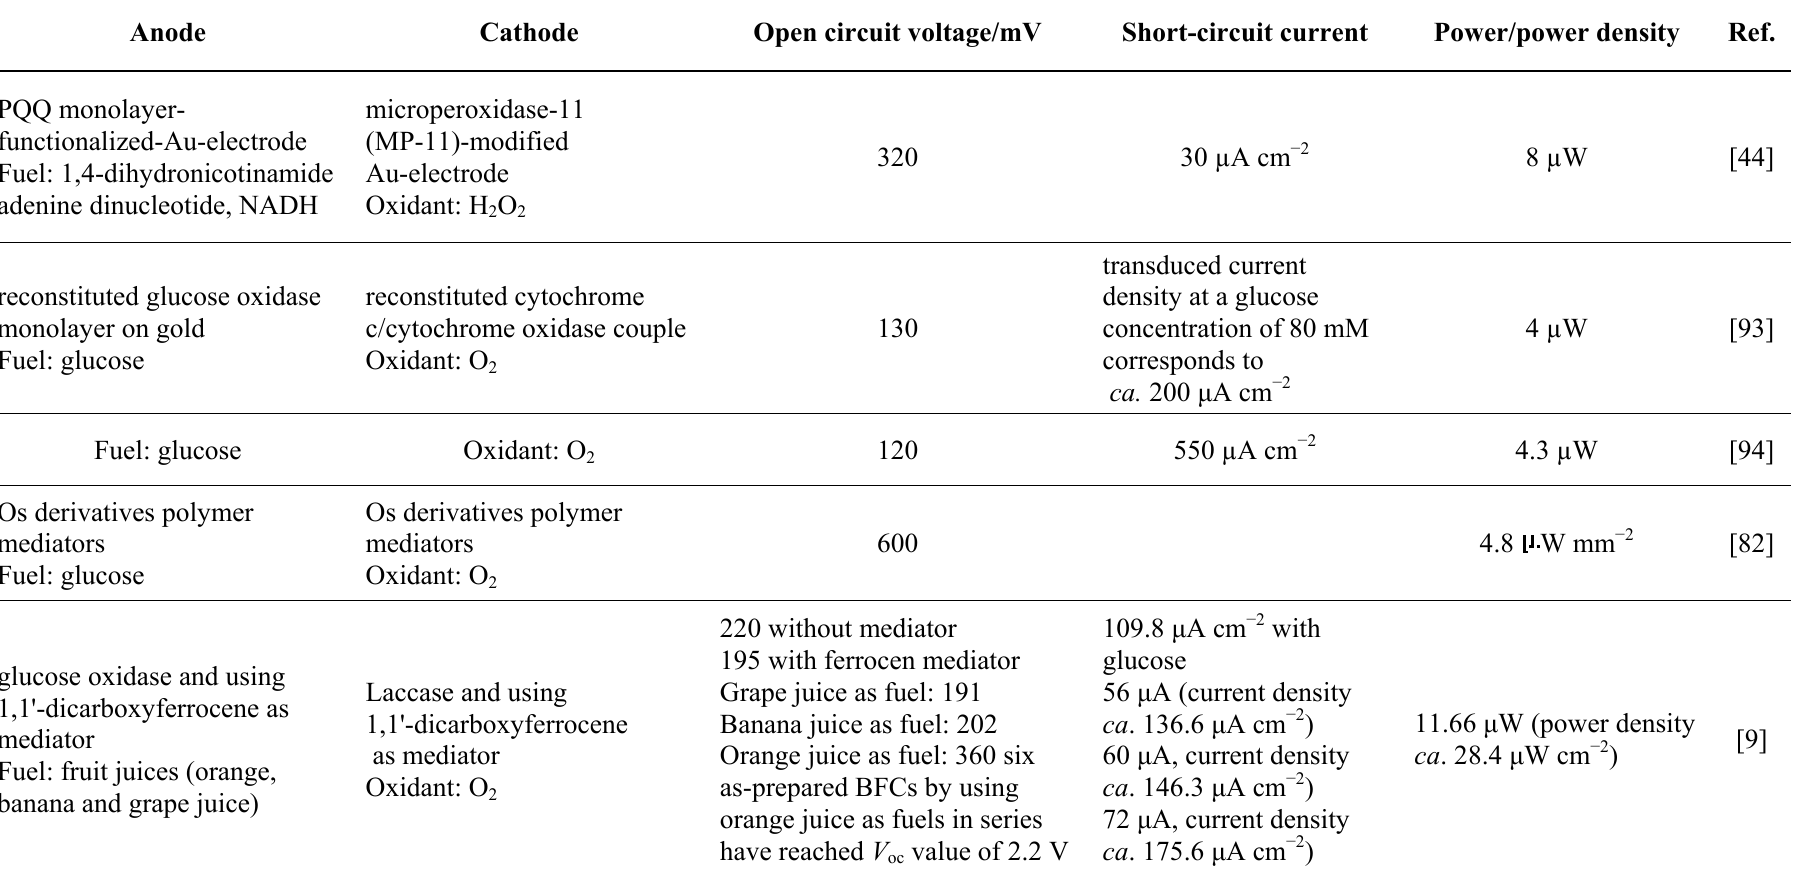
Table 1. Summary of enzymatic biofuel cell